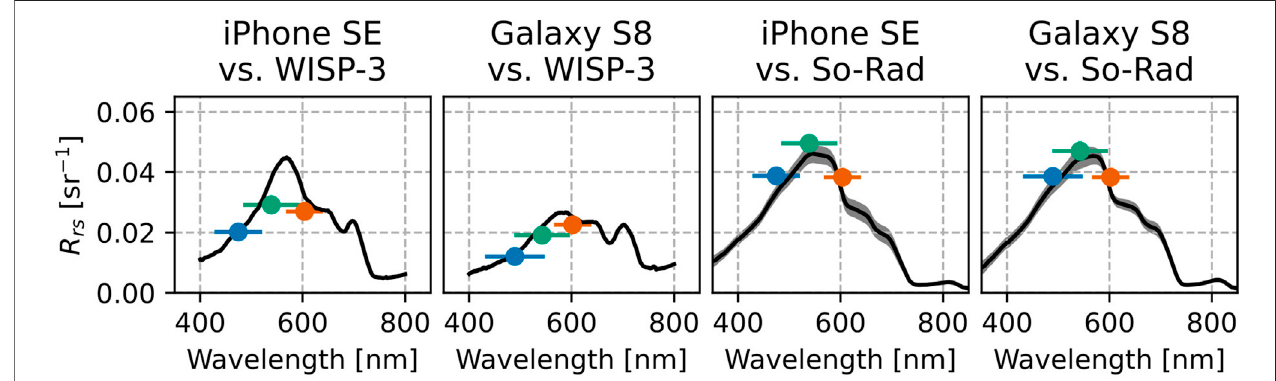
FIGURE 9| Examples ofsmartphone vs. reference R rs match-ups at different stations. The solidlines show the reference spectrum, with uncertainties in gray. The RGB dots show the smartphone data, with error bars indicating the effective bandwidth (horizontal) and R rs uncertainty (vertical). In some panels, the vertical error bars are smaller than the data point